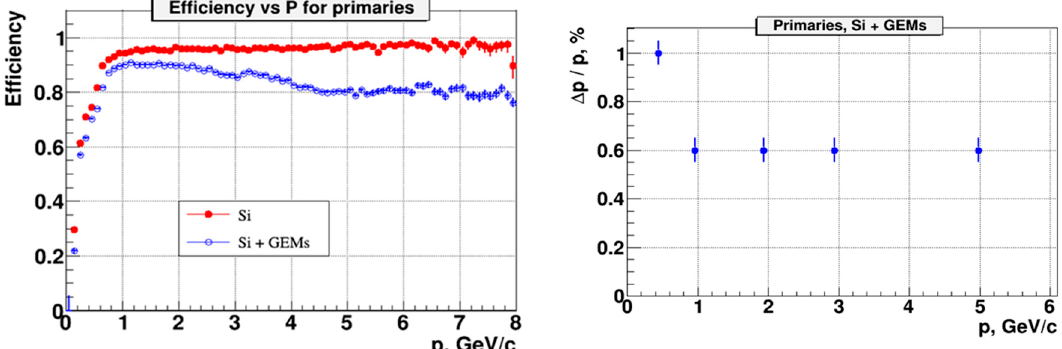
Figure 5. Left panel : Reconstruction efficiency as a function of momentum for primary tracks with a minimum of 4 hits in the Si stations only ( red histogram ), and in the Si + GEM stations ( blue histogram ). Right panel : Momentum resolution for primary tracks emitted in the central Au + Au collisions at a beam kinetic energy of 4 A GeV reconstructed in the BM@N hybrid tracking system as a function of momentum.